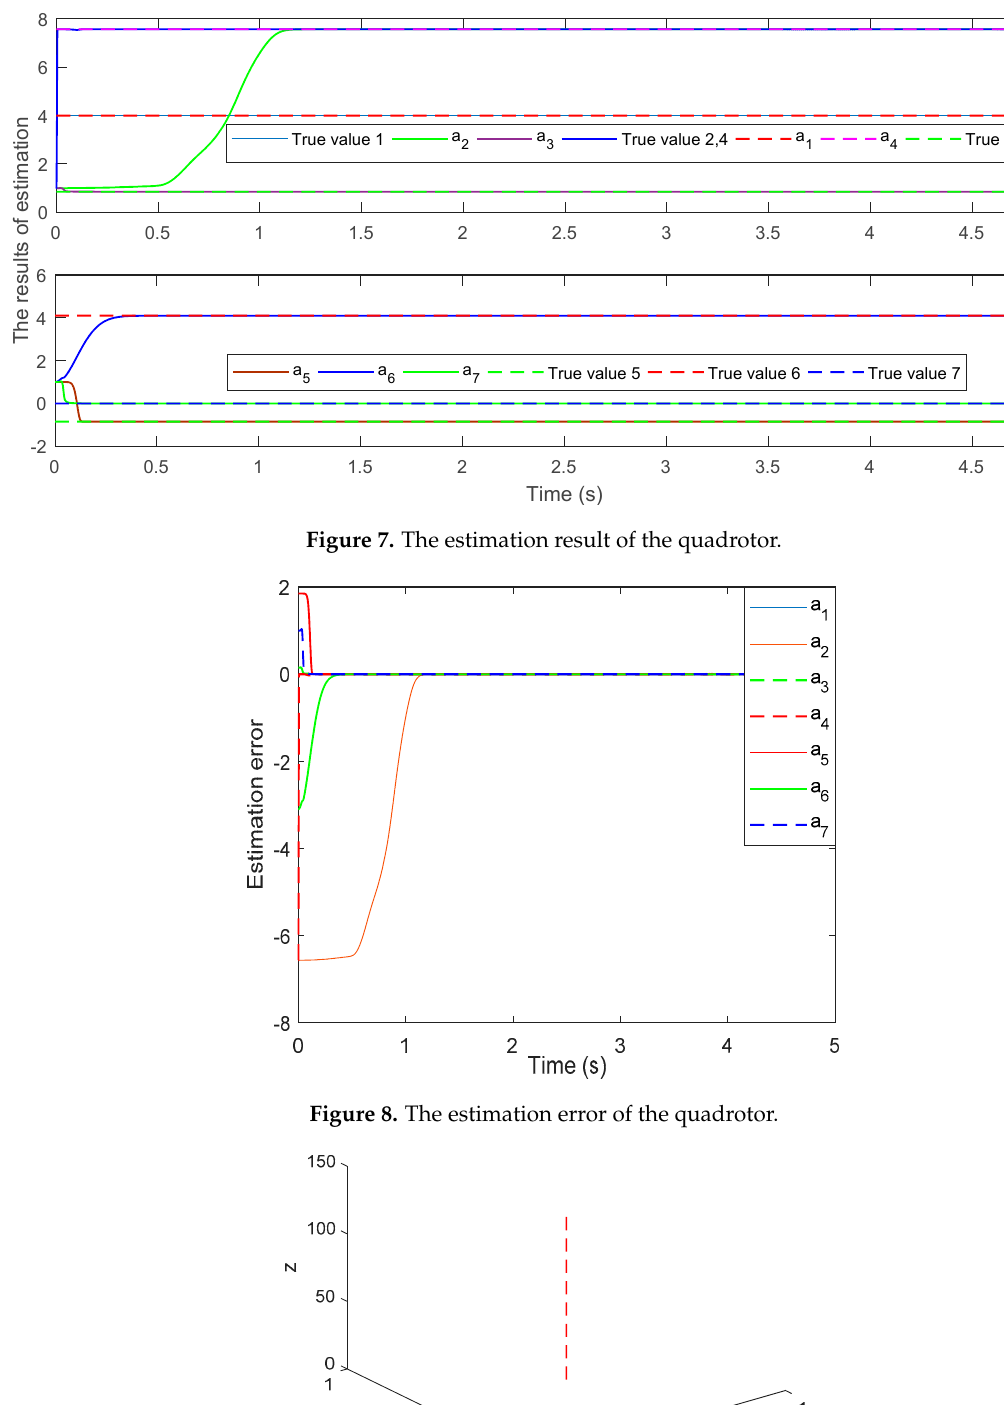
Figure 6. The diagram of the structure of the quadrotor.